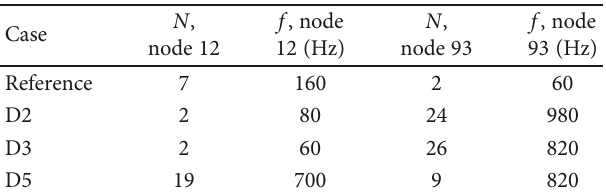
Table 6: Number of superharmonic peaks ( N ) and maximum superharmonic frequency content ( f